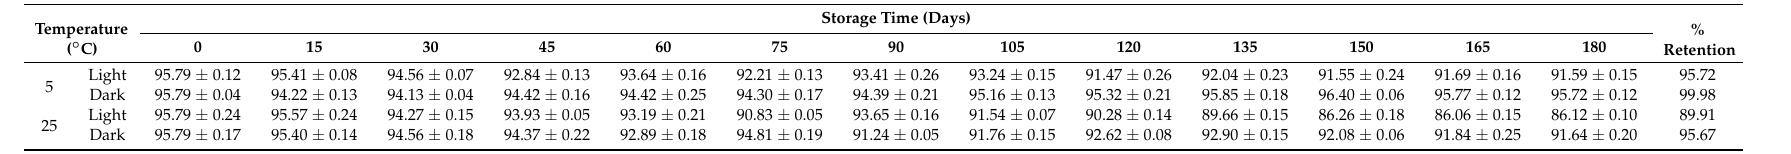
Table 2. Stability of 2,2-diphenyl-1-picrylhydrazyl (DPPH • ) antioxidant activity (% inhibition) of dried Piper betle extracts under different storage temperatures and light for 6 months 1